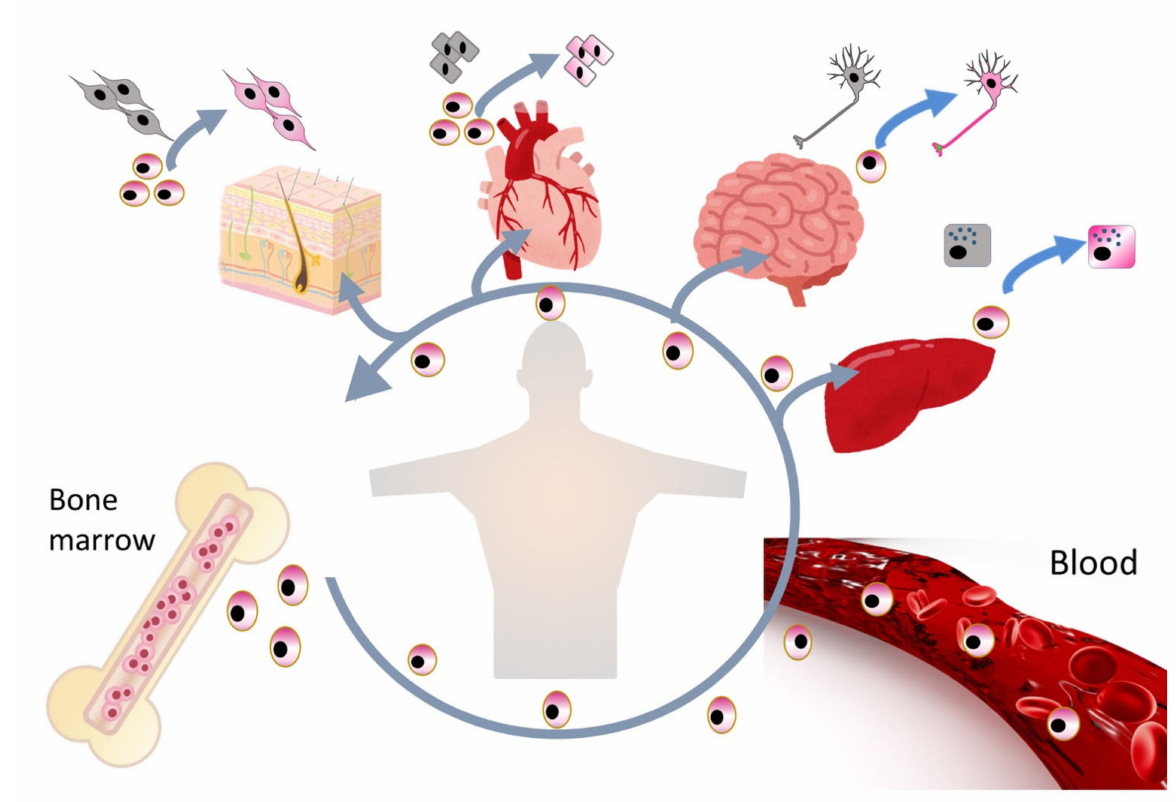
Figure 2. Daily reparative activity of endogenous Muse cells. Muse cells in the bone marrow are considered to be constantly mobilized to the peripheral blood and supplied to every organ, where they replace minutely damaged/apoptotic cells by spontaneous